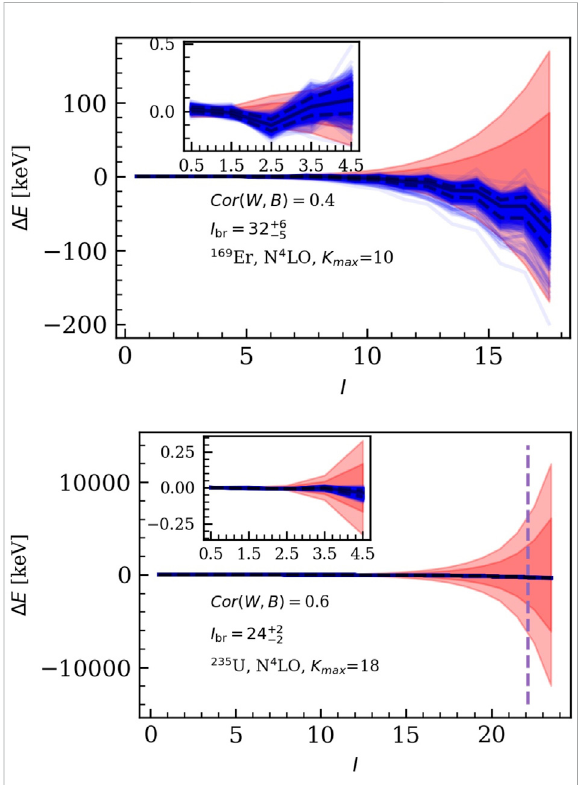
FIGURE 8 The posterior predictive distribution for energy-level residuals at N 4 LO and k max =10 for 169 Er and I max =17.5 (top panel) and at k max =18 for 235 U and I max =23.5 (bottom panel). The dark and light red bands show the truncation error plus the experimental error at 68% and 95% credible levels respectively. Thelighterbluelinesconnecttheenergyresidualscalculatedfrom the distribution of the LECs. The solid black line represents the median of the distribution and the dashed lines indicate the 16th and 84th percentiles. The correlation shown on the plot is the highest correlation between any LEC and any error-model parameter. I br was determined from the distribution of W . The dashedpurplelineshowsthelowerlimitof I br .Theinsetontheplot shows the residuals on the fi rst fi ve levels with an altered y -axis scale.